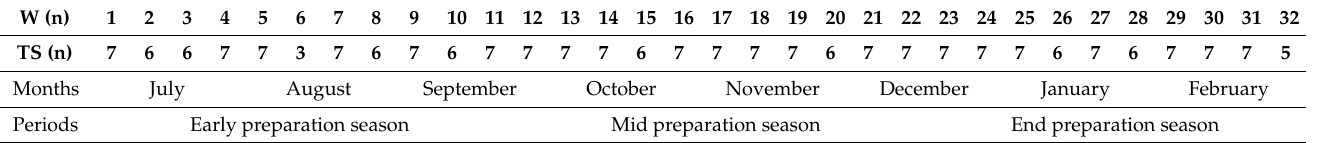
Table 5. During monitoring in full